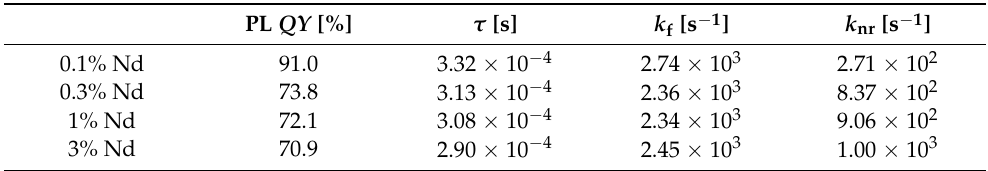
Figure 4. PL decay curves of LaMgAl 11 O 19 :Nd monitored at 900 nm when excited at 580 nm.